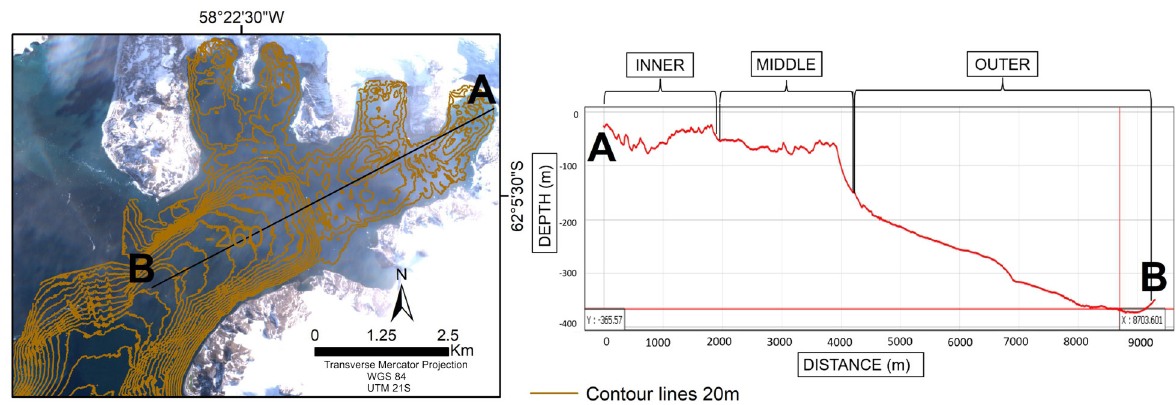
Figure 6. (1) Profile location map and contour topographic map with 20 m depth intervals; (2) Submarine topographic profile of MI. Letter A indicates the beginning of the profile and B the end of the profile.